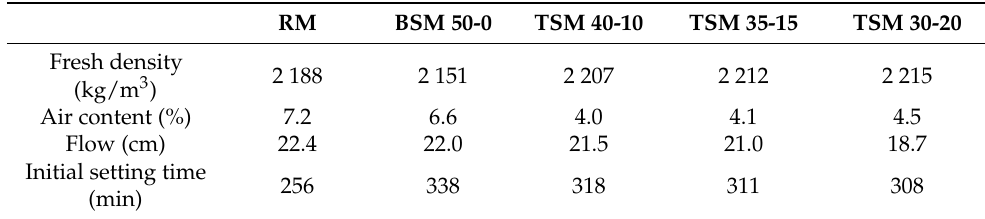
Table 9. Blended cement mortar